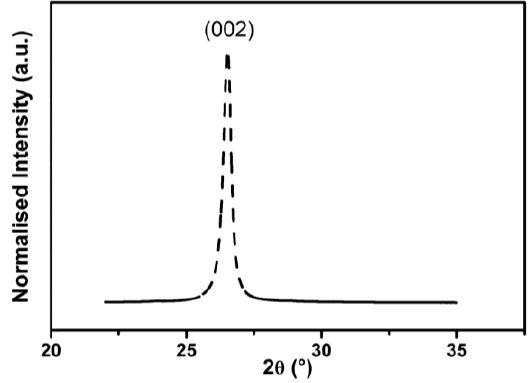
Figure 2. WAXS spectrum for the MO-1 graphene pellets from Graphene Supermarket.